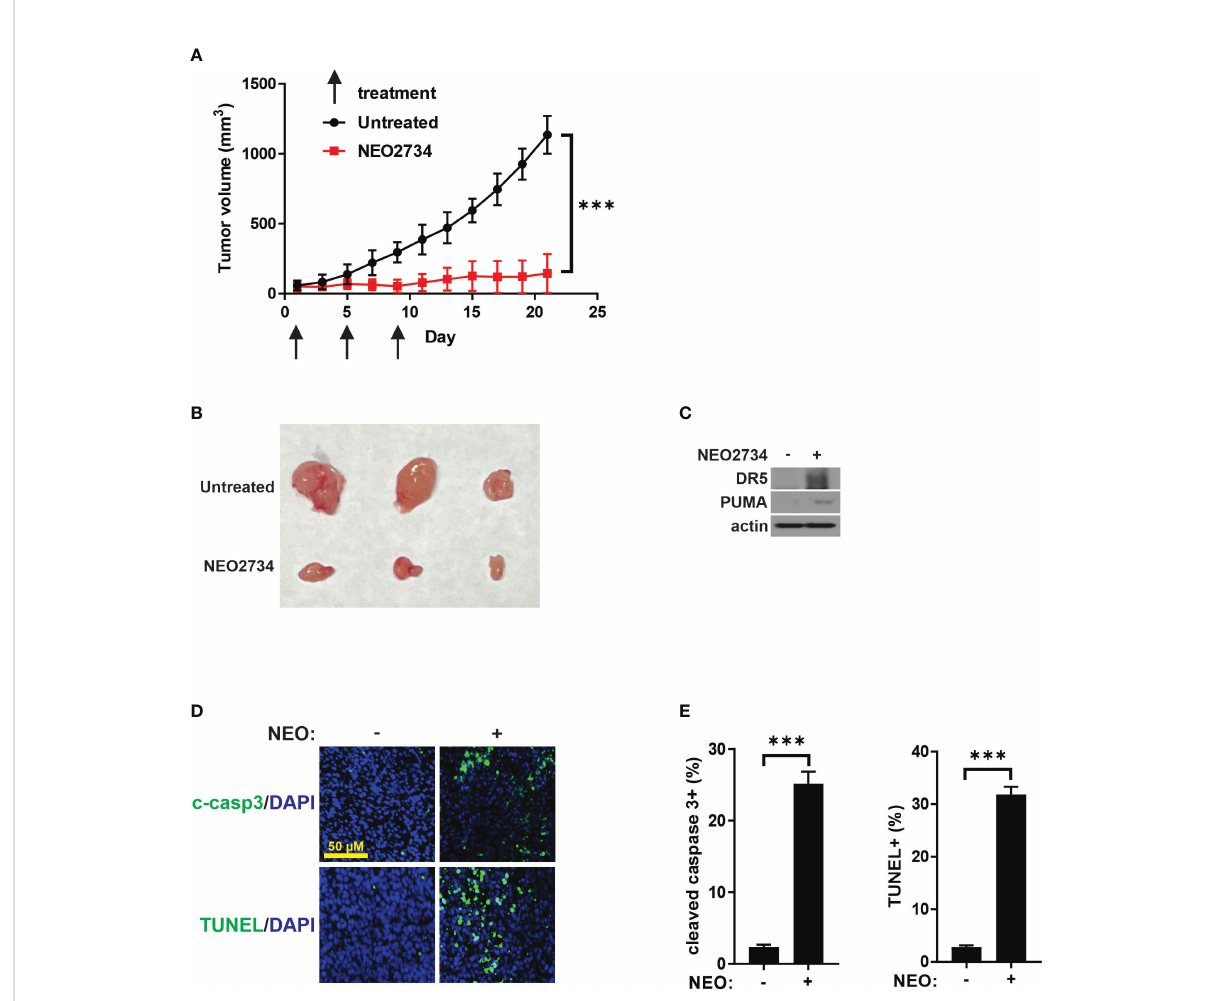
FIGURE 6 NEO2734 induces CRC apoptosis in vivo . (A) Growth curves of HCT116 tumor xenografts implanted in fl anks of nude mice. Treatments were started after tumors reached 50-100 mm 3 in size. Tumor volumes were estimated by the formula V=w^2*l/2 (V=volume, w=width or short dimension of tumor, l=length or long dimension of tumor). Results are the mean and S.D. of 6 independent tumors. (B) Representative photographs of NEO2734-treated and control HCT116 xenograft tumors dissected from mice after sacri fi ce on day 21. (C) Western blot of HCT116 xenograft tumors with indicated antibodies. (D) Representative immuno fl uorescence staining of indicated markers in control versus NEO2734-treated xenografts. (E) Quanti fi cation of c-casp3 and TUNEL positive cells in xenografts. Mean and S.D. of 6 independent tumors are shown (***p <